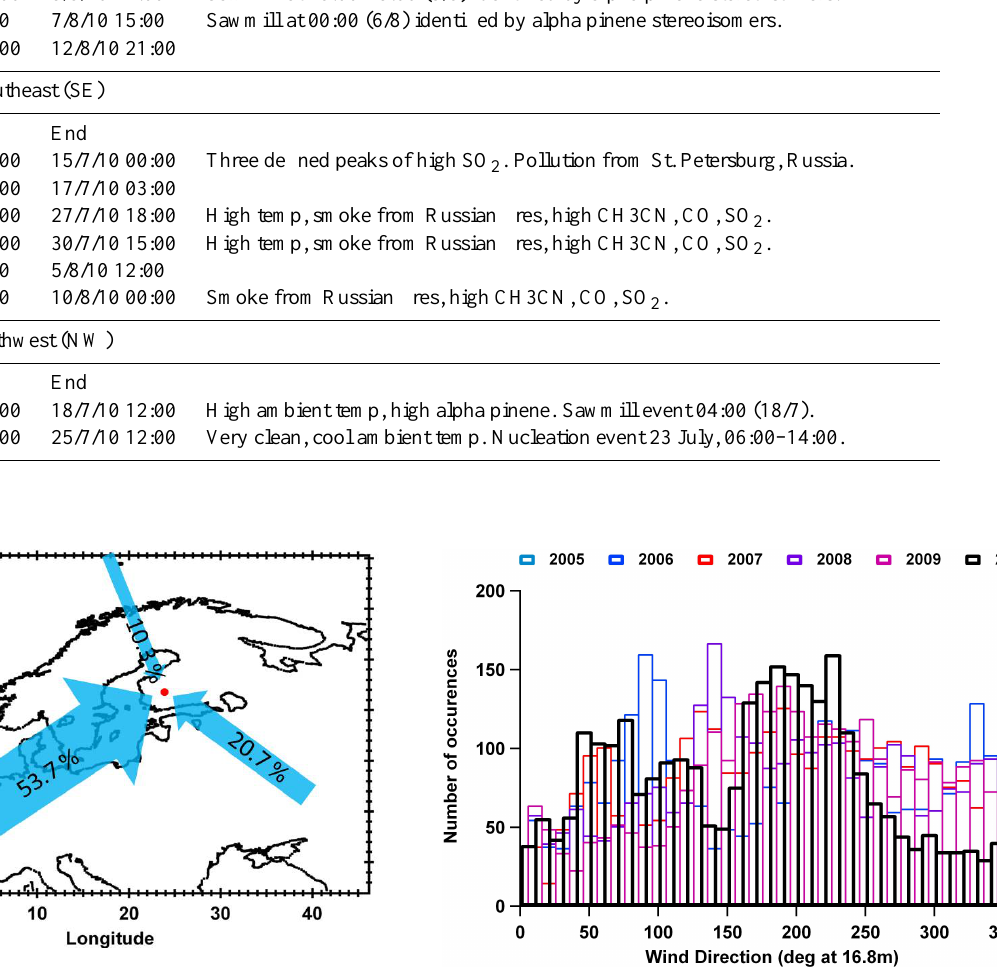
Fig. 3a. A map showing schematically the proportion of airmasses influencing the site during the HUMPPA-COPEC campaign, de- duced from 3 day back trajectory analysis and segregated into wind sectors (NW, NE, SW, SE). The arrow sizes approximate to the pro- portion of trajectories and the statistics of the analysis are given in Table 3. events (associated with frontal passages) were experienced at the site. On several occasions these rain events and associ- ated lightning caused power disruption at the site.